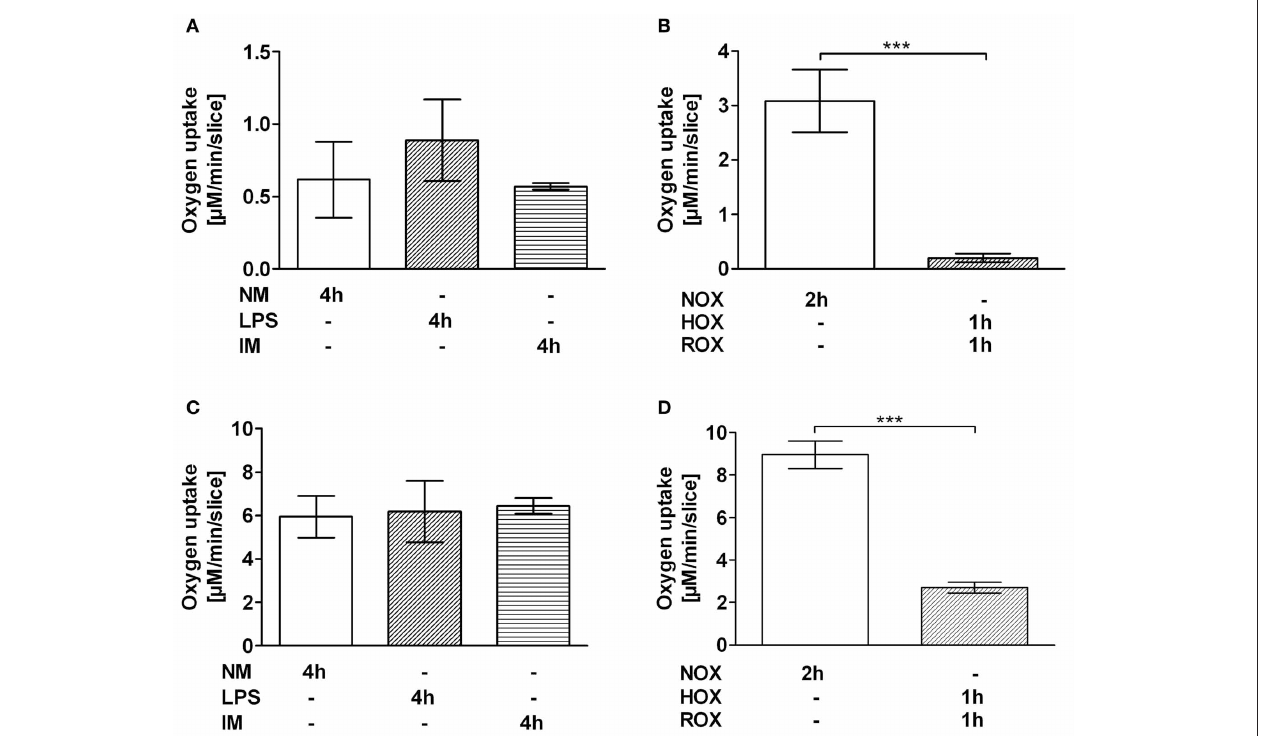
FIGURE 3 | Effect of IM (A,C) and HOX/ROX (B,D) on the mitochondrial state 3 respiration. PCLS mitochondria were stimulated with glutamate + malate (A,B) or succinate (C,D) . Transition to state 3 respiration was induced by addition of ADP (1mM). Mitochondrial function was determined after 4h of PCLS incubation in NM only or NM containing LPS or LPS + IM at 37 ◦ C